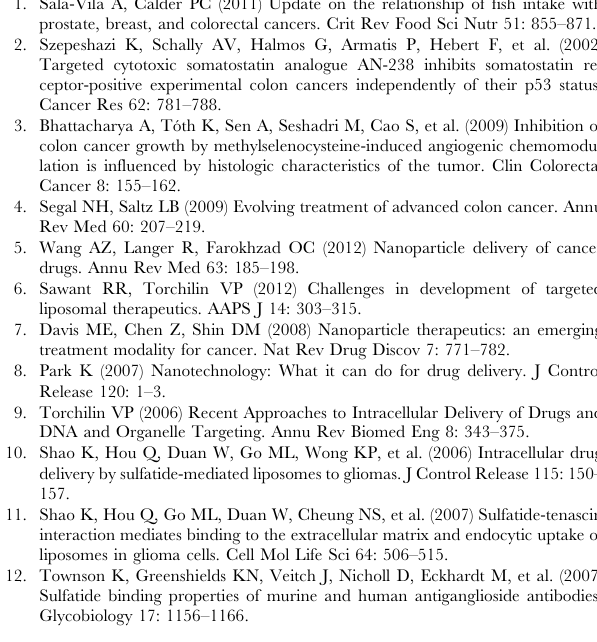
Figure S1 Intracellular uptake of SCL-DOX in HT-29 cells. HT-29 cells were incubated with 2 m g/mL free DOX or equivalent SCL-DOX for 24 h. Following two washes with PBS, cells were imaged with a confocal fluorescence microscope. ( A ) Cells treated with free DOX. ( B ) Cells treated with SLC-DOX. Red: fluorescence from DOX; blue: nuclei stained with Hoechst 33342. Scale bars: 200 m m. (TIF) Figure S2 Intracellular retention of SCL-DOX in HT-29 cells. HT-29 cells were first incubated with 2 m g/mL free DOX or equivalent SCL-DOX for 24 h. After two washes with PBS to remove the drugs, cells were cultured in fresh full culture medium followed by imaging serially at 1 h, 2 h, 4 h and 24 h using fluorescence confocal microscopy. ( A ) Cells treated with free DOX. ( B ) Cells treated with SLC-DOX. Red: fluorescence from DOX; blue: nuclei stained with Hoechst 33342. Scale bars: 200 m m. (TIF)